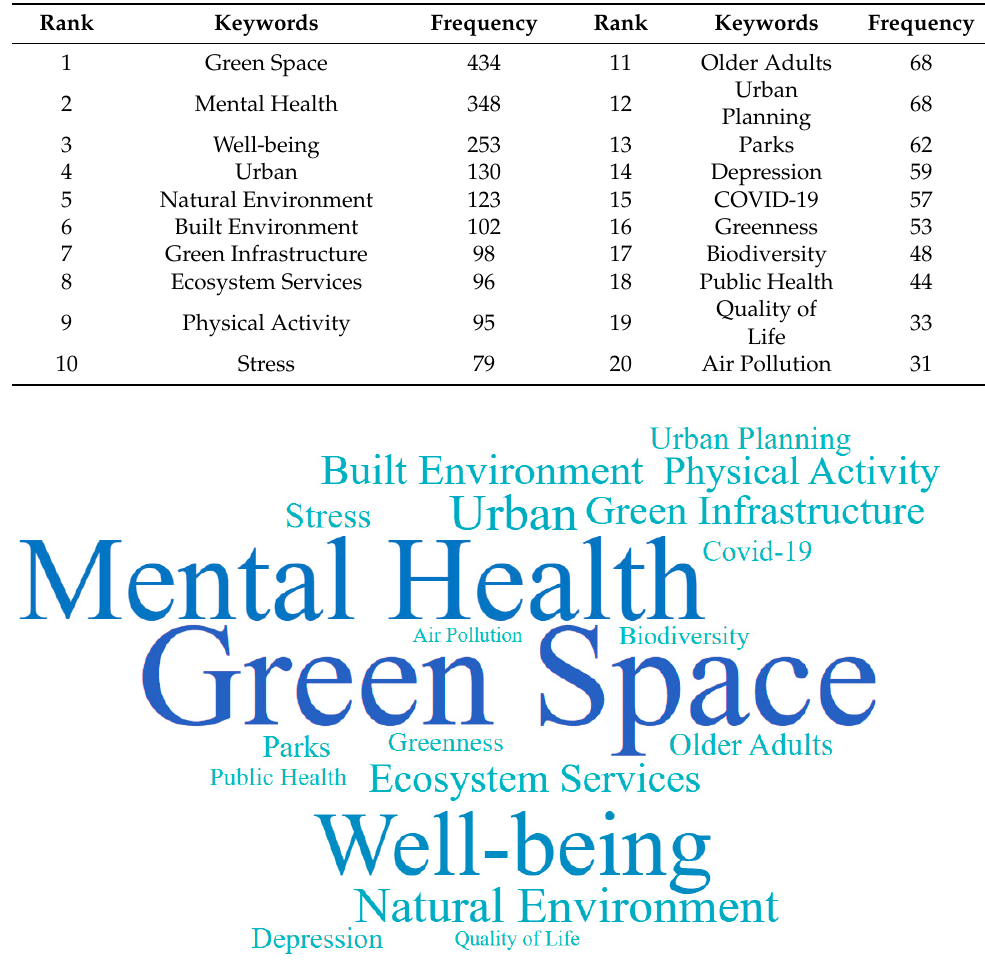
Figure 4. Word cloud of keywords for the study of green space and senior mental health. Note: The keyword size in the diagram represents the frequency of the keywords during searches. Table 3. Top 20 keywords for the study of green space and senior mental health.